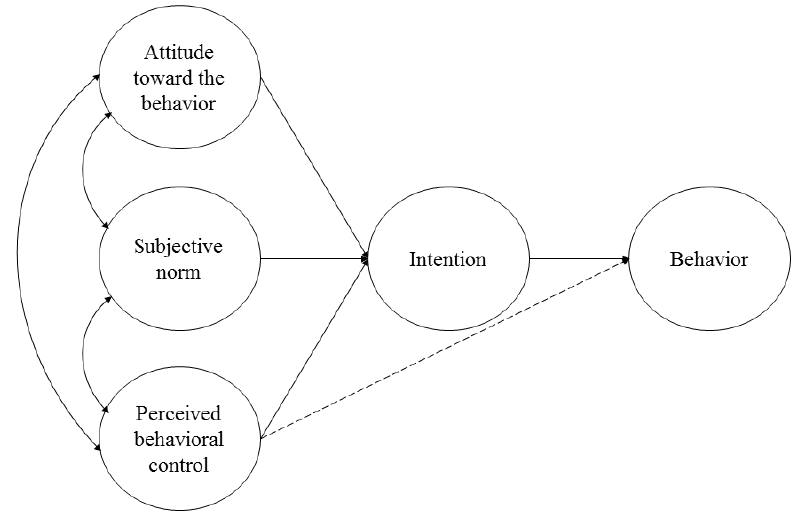
Figure 1. Theory of Planned Behavior [10].